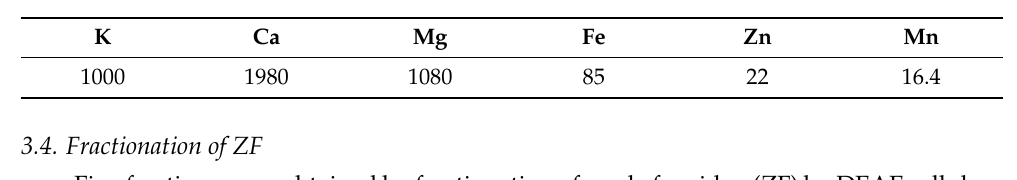
Table 4. The mineral content of Sargassum zhangii (g/100 g protein). The minerals tested include K, Ca, Mg, Fe, Zn, and